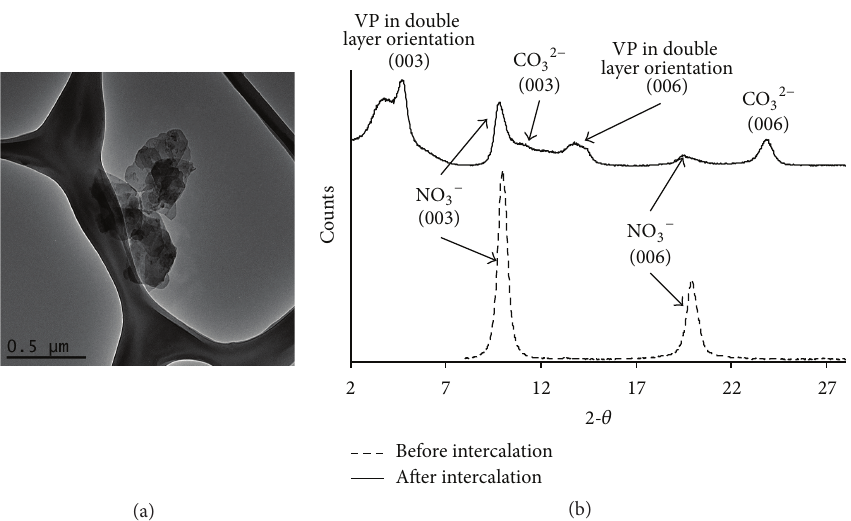
Figure 6: TEM bright field micrograph of Zn 1.91 Al(OH) 6 (NO 3 ,0.5CO 3 ) 0.584 (VP) 0.416 ⋅ x H 2 O nanoparticles is shown in (a), and XRD analysis before and after intercalation shown in (b) shows the partial replacement of the intercalated NO 3− by VP and CO 32− (as minor contaminants).